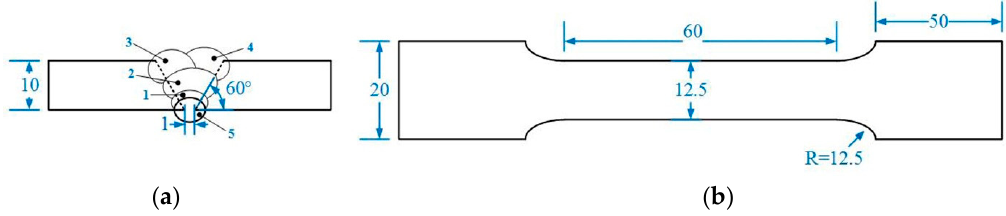
Figure 2. Welding pass sequence and tensile specimens: ( a ) Welding pass sequence; ( b ) Dimensions of the tensile specimens (the thickness of tensile specimens is 8 mm; all dimensions are in millimeter). Table 3. The welding parameters and the heat inputs.